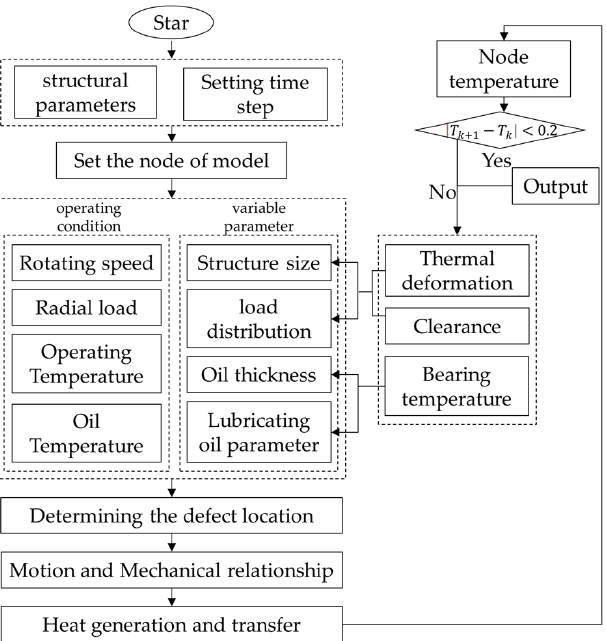
Figure 5. Transient temperature calculation flow of faulty bearing system.